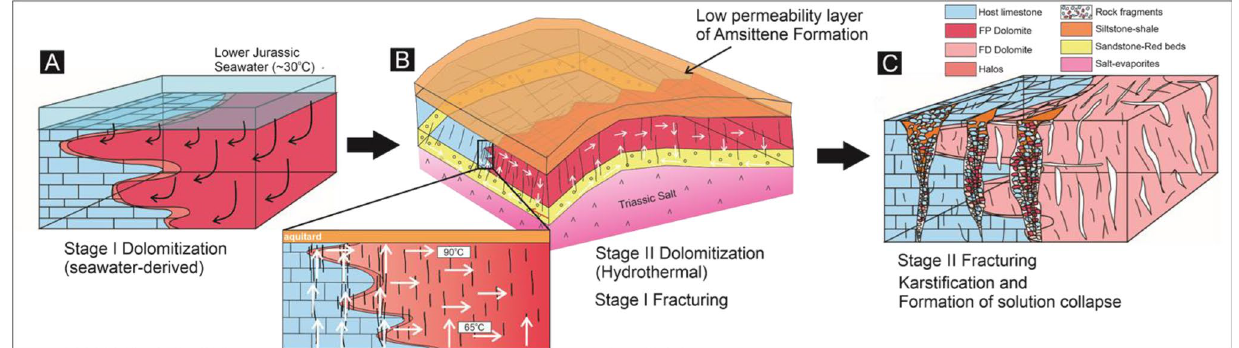
Figure 6. Conceptual model on the evolution of dolomitization, fracture system and karstification in the study area. ( A ) Early, seawater-derived dolomitization which predated fracturing. ( B ) Formation of fracture corridors, preferentially along the dolomite-limestone boundary. This provides vertical fluid pathways for upward flux of warm, Mg-rich fluids. ( C ) The last stage represents the development of solution collapse during the interaction between groundwater/meteoric water and carbonate rocks associated with the formation of Cenozoic Alpine